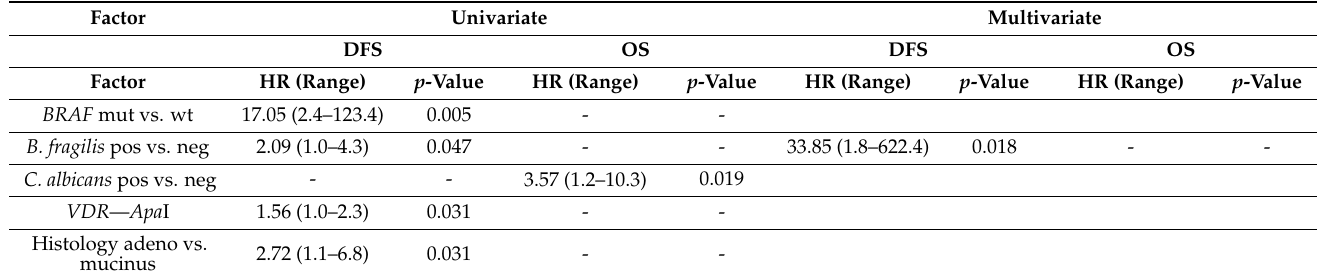
Table 6. Univariate and multivariate Cox regression analysis for disease free (DFS) and overall (OS)